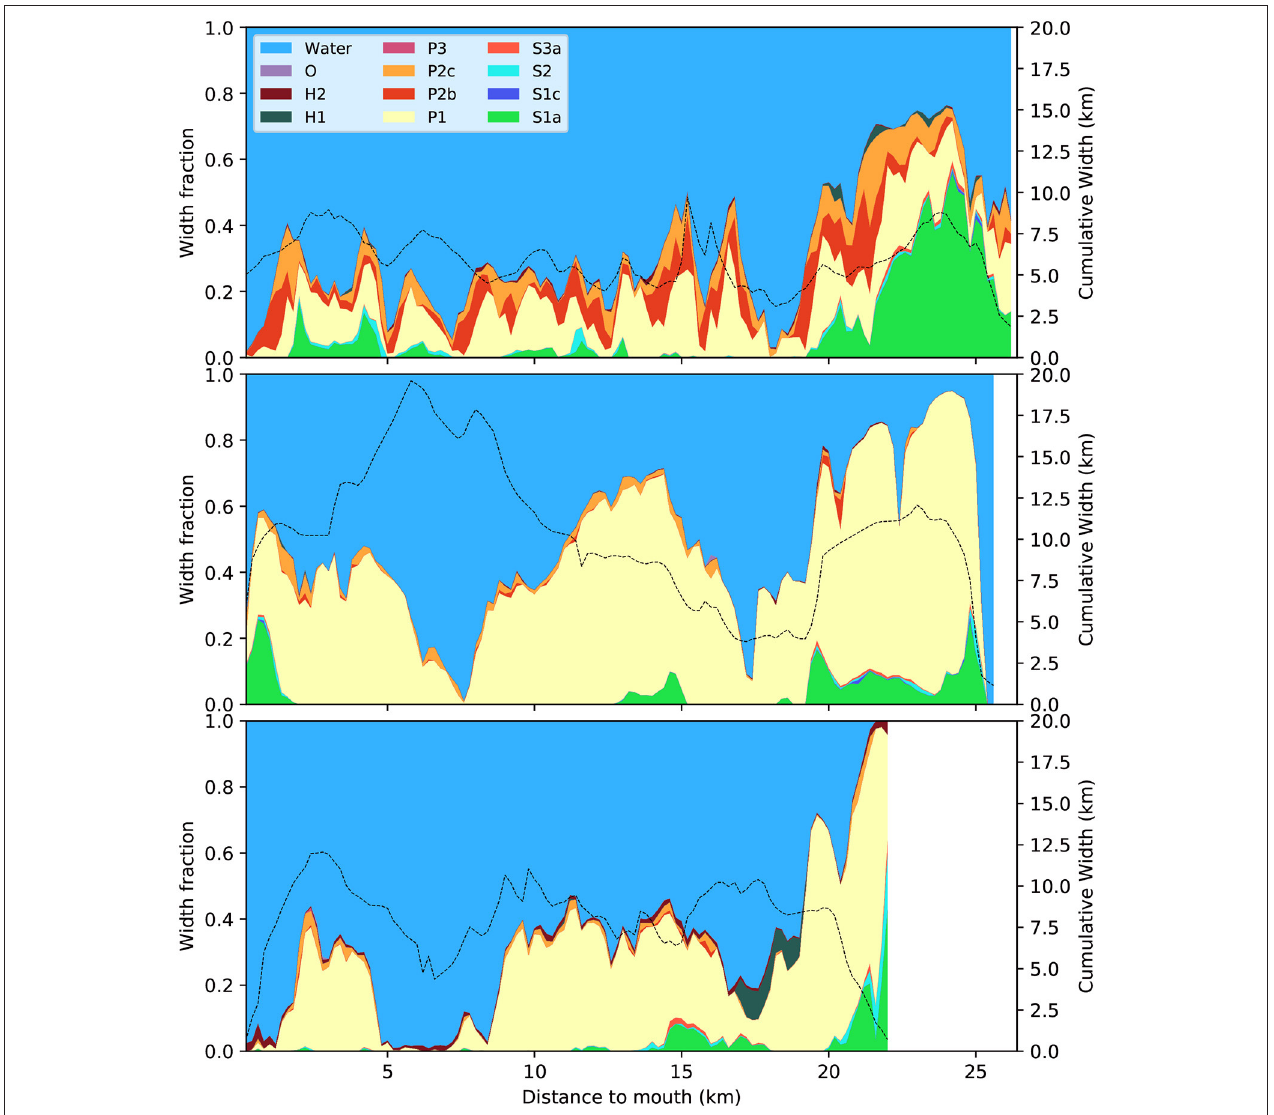
FIGURE 4 | Distribution of biogeomorphological classes as relative width along the Western Scheldt (top) , Eems-Dollard (middle) , and Eastern Scheldt (bottom) . Cumulative estuary width, the sum of all classes including water, is plotted as the dashed black line for the right vertical axis. Distance is measured along a smooth centerline between the banks from the narrowest cross-section in the seaward mouth. See Table 2 for explanation of the legend. The data underlying these graphs are provided in Supplementary Material .